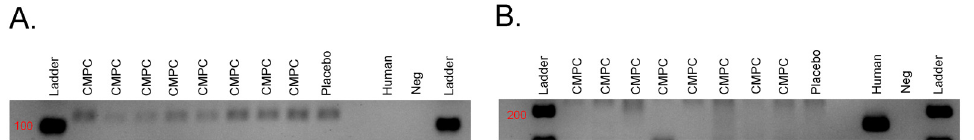
Fig 8. QPCR. A. QPCR shows presence of genomic pig DNA (Gapdh) in all pig tissues treated with CMPC or placebo and absence of pig DNA in the sample containing human CMPCs (Human) and the negative control (Neg) containing H2O used for PCR. B. Human genomic DNA (HLA-DMA) was detected in the sample containing human CMPCs (Human), but was absent in all the pig tissues (CMPC and Placebo) and the negative control (Neg) containing H2O used for